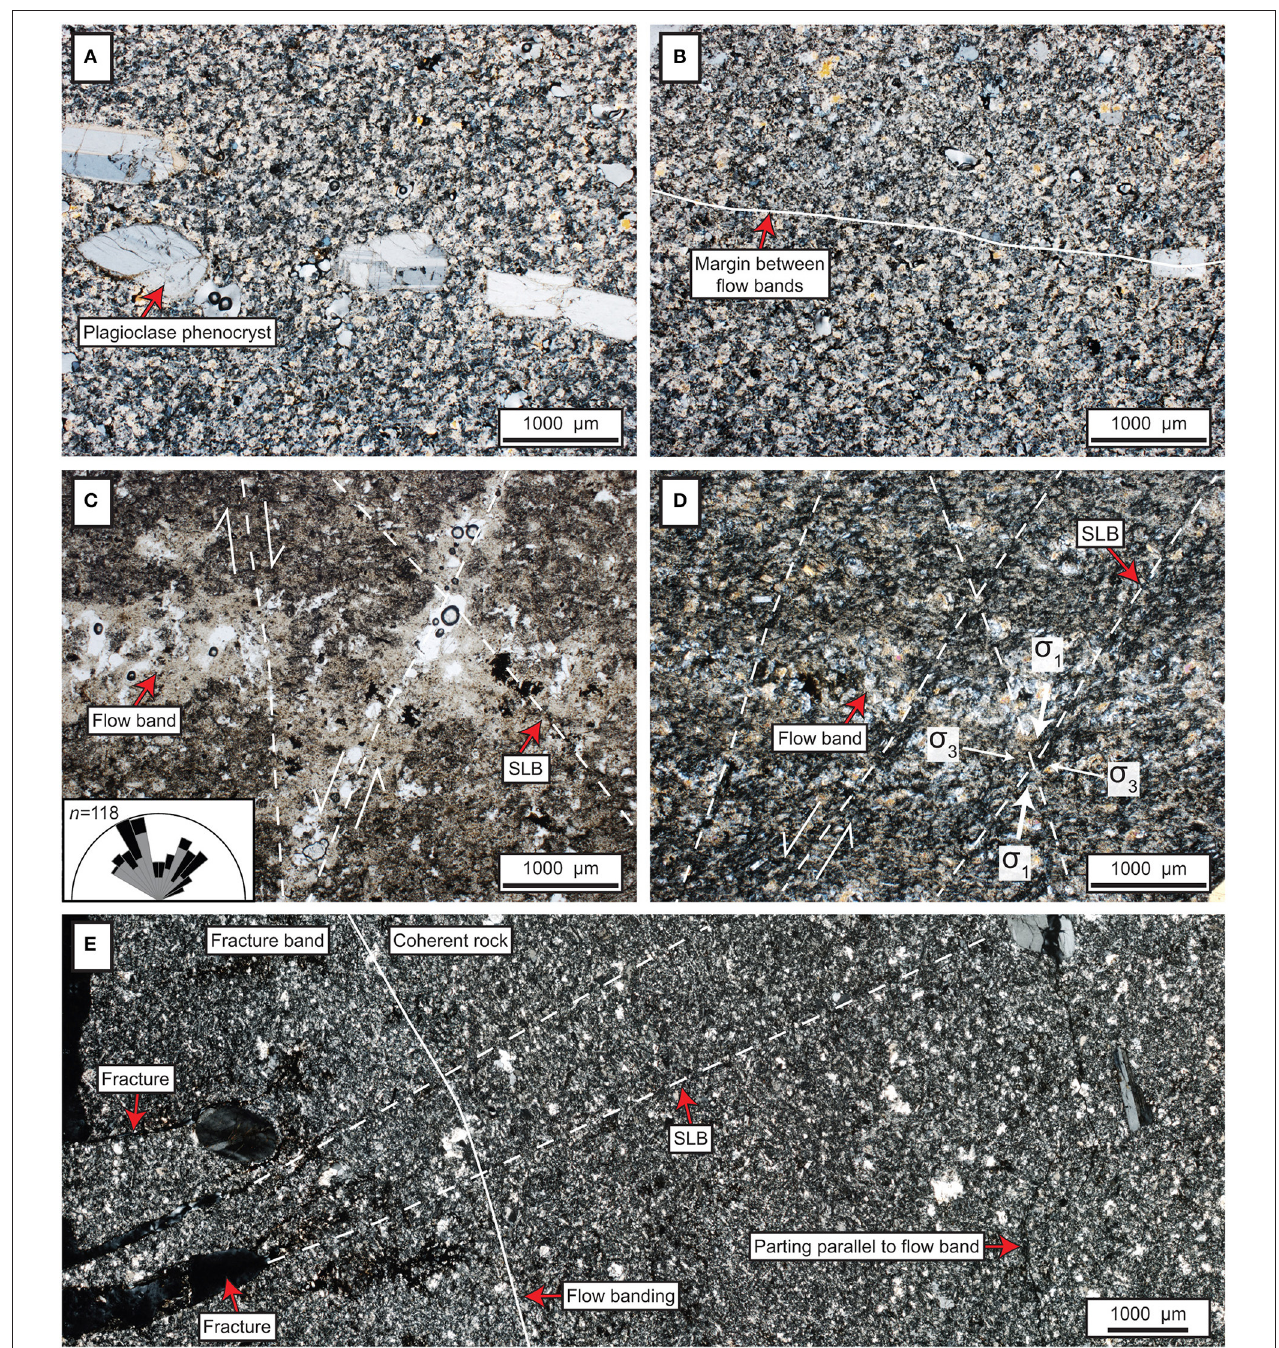
FIGURE 4 | (A) Microphotograph of aligned euhedral plagioclase phenocrysts in the Sandfell laccolith indicative of magma flow (crossed polars (B) Microphotograph showing discrete variation in crystallinity in the rhyolite groundmass (CPL). The transition from fine-grained subhedral groundmass phases (bottom half of image) to dominantly anhedral crystal phases (top half of image) is marked by the white line. Crystals in the groundmass become increasingly anhedral with indistinct crystal boundaries adjacent to fracture bands. (C) Microphotograph of flow banding in sample close to the roof contact of Lower Sandfell (plane polarized PPL). SLBs (indicated by dashed lines) displace the primary flow band. Inset shows orientations of SLBs in a bi-directional rose plot (black bars, n = and fracture orientations (gray bars, n 39) relative to flow bands. The acute angle of the conjugate SLBs is smaller in thin sections perpendicular to the strike of the = flow bands. (D) Microphotograph of a flow band in the Sandfell rhyolite in a sample from SE of Upper Sandfell (CPL). The flow bands are characterized by variations in grain-size. The dark SLBs, some marked by white dashed lines, are oriented oblique to the flow banding. (E) CPL microphotograph of fracture band and rhyolite groundmass next to fracture bands. The strain-localization bands (SLBs) (white dashed lines) are observed to transition into fractures. Note the change in groundmass crystallinity and texture closer to the fracture band. All thin sections are oriented perpendicular to the strike or dip-direction of the flow bands.